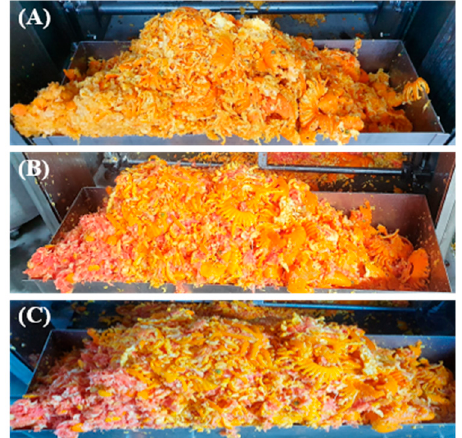
Figure 9. Image of the orange by-product of the standard variety Nave ( A ) and the red-fleshed varieties Cara Cara ( B ) and Kirkwood ( C ) generated during the industrial juice extraction. Table 5. Carotenoid content and composition ( μ g/g DW) of Navel, Cara Cara, and Kirkwood orange by-products.